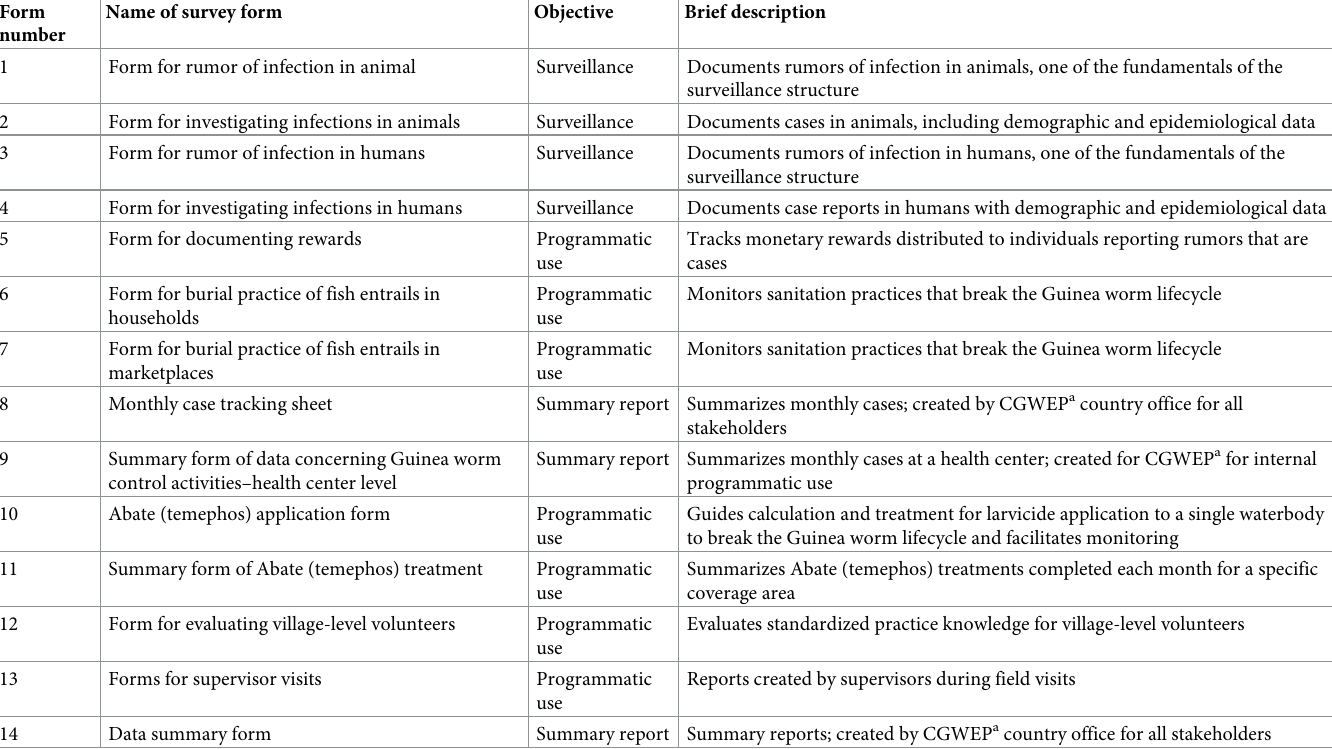
Table 2. Description of survey forms used by CGWEP a to collect